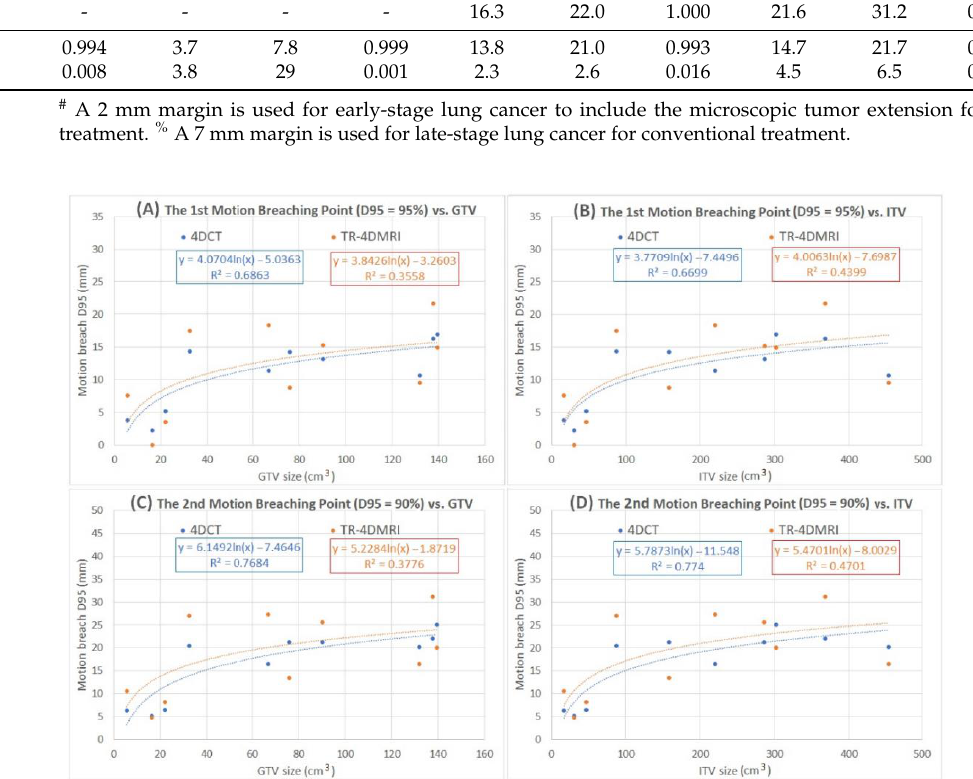
Figure 4. The first and second PTV dose-coverage breaching points (D95% = 95% in the top row and D95% = 90% in the bottom row) as a function of GTV ( A , C ) and ITV ( B , D ). The logarithm fittings are better than linear fittings (not shown), suggesting that the breaching points are more sensitive to motion amplitude increase for smaller tumors than larger tumors. The “critical mass” of the change is around 25-30 cm 3 for GTV and 80-100 cm 3 for ITV. The 4DCT-based results (blue) produce better fitting with higher R 2 than the TR-4DMRI-based results (orange), because of higher motion variations in multi-breath waveforms than single-breath waveforms.